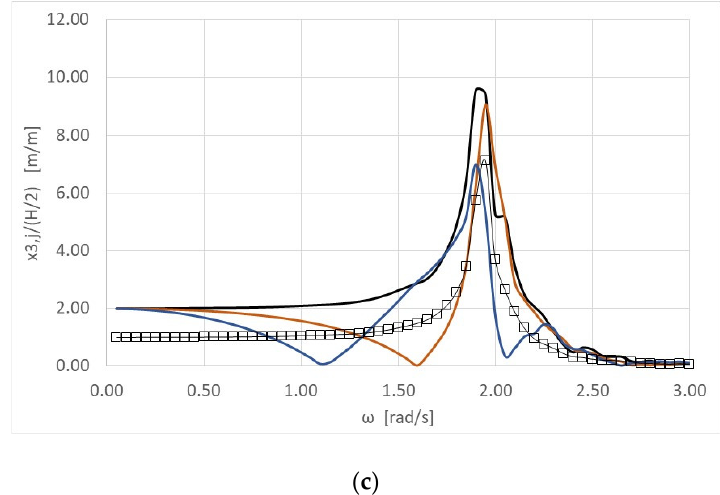
Figure 5. Dimensionless heave displacement of the 1st WEC, j = 1, of the rectangular to the wall array, against ω , for three different examined distances from the vertical wall and three wave heading angles. Comparisons are made for the heave displacements of the same converter of the array without the presence of the breakwater: ( a ) θ = 0°; ( b ) θ = 45°; ( c ) θ = 60°.